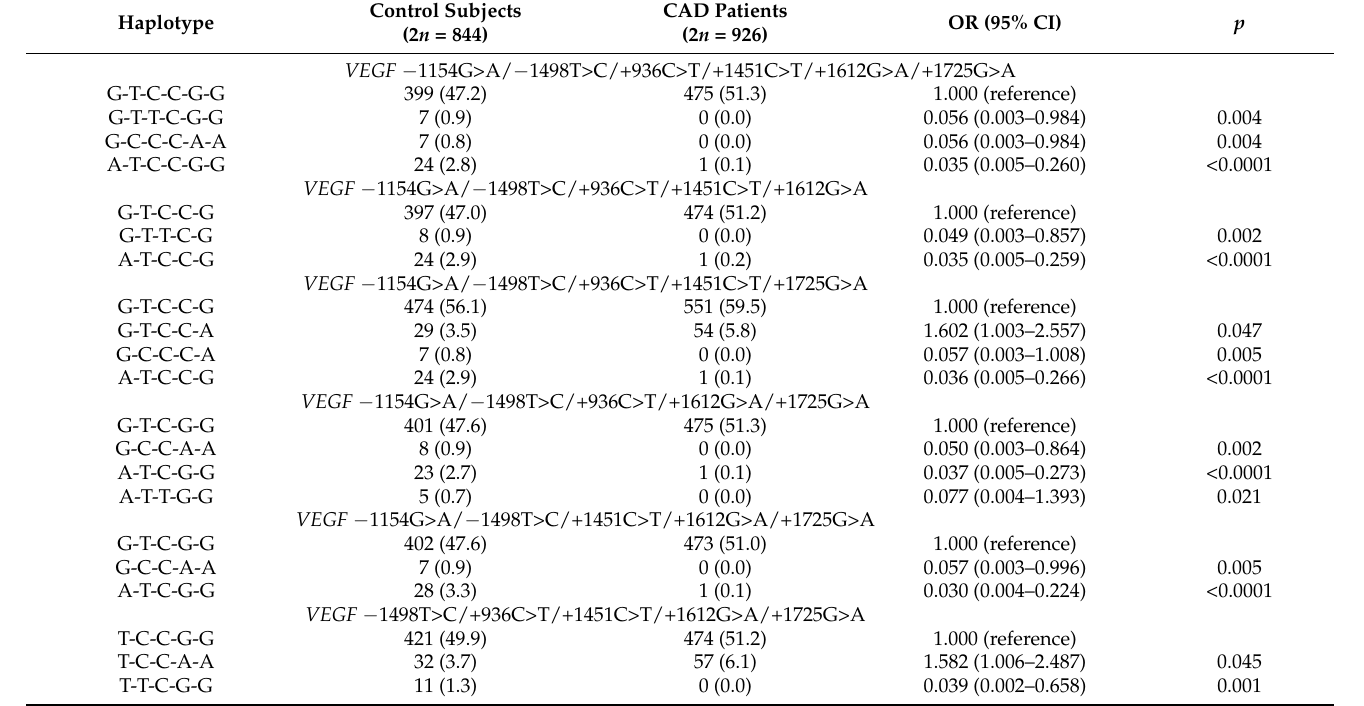
Table 4. Haplotype analysis of VEGF polymorphisms in CAD patients and controls